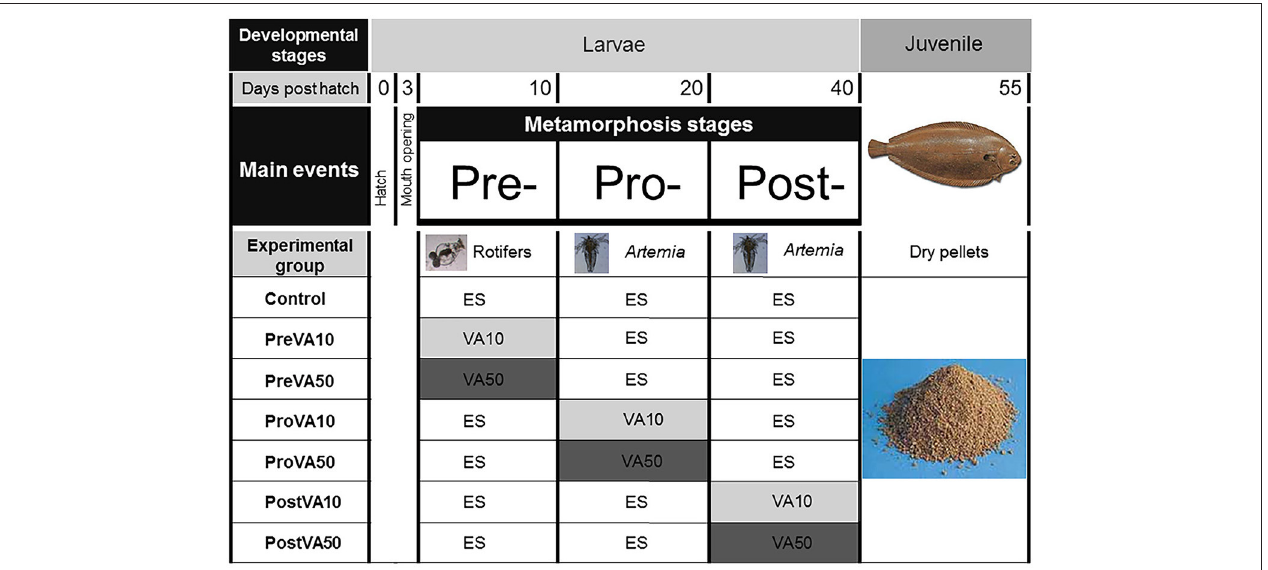
FIGURE 1 | Experimental design of the present study showing from top to bottom: (i) Developmental stages considered ( larvae and juvenile ); (ii) Days post hatch ( 0 , 3 , 10 , 20 , 41 , and 55 ); (iii) Main events during larval development ( hatch , mouth opening , pre-metamorphosis , pro-metamorphosis , post-metamorphosis ); (iv) Experimental groups listed on the left column, graphically depicted in central columns: Control , larvae fed rotifers and Artemia metanauplii enriched with Easy Selco (ES); PreVA10 , larvae fed rotifers enriched with ES supplemented with a dietary content 10 fold above normal (VA10) and afterwards Artemia metanauplii enriched with ES; PreVA50 , larvae fed rotifers enriched with ES supplemented with a dietary content 50 fold above normal (VA50) and afterwards Artemia metanauplii enriched with ES; ProVA10 , larvae fed rotifers enriched with ES, Artemia metanauplii enriched with ES supplemented with a dietary content in 10 fold above normal (VA10) during pro-metamorphosis (from 10 to 20 dph) and afterwards Artemia metanauplii enriched with ES; ProVA50 , larvae fed rotifers enriched with ES, Artemia metanauplii enriched with ES supplemented with a dietary content in 50 fold above normal (VA50) during pro-metamorphosis (from 10 to 20 dph) and afterwards Artemia metanauplii enriched with ES; PostVA10 , larvae fed rotifers enriched with ES, with Artemia metanauplii enriched with ES (from 10 to 20 dph) and afterwards Artemia metanauplii enriched with ES supplemented with a dietary content in 10 fold above normal (VA10) during post-metamorphosis (from 21 to 41 dph); PostVA50 , larvae fed rotifers enriched with ES, with Artemia metanauplii enriched with ES (from 10 to 20 dph) and afterwards Artemia metanauplii enriched with ES supplemented with a dietary content in 50 fold above normal (VA50) during post-metamorphosis (from 21 to 40 dph); and weaning process for all experimental groups on the right column from 41 to 55